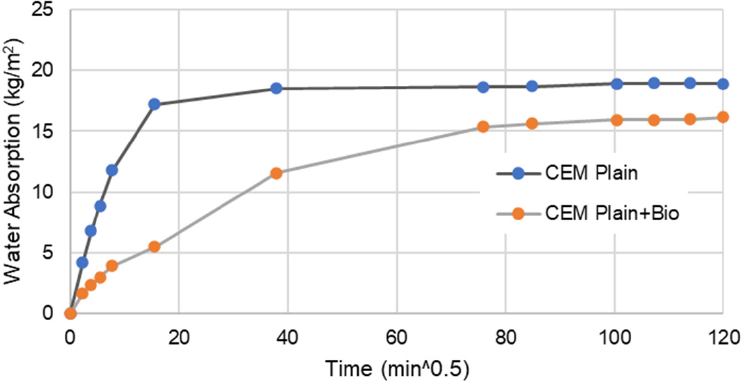
Figure 6. Water absorption for bio and non-bio earth mortar samples during the first 1 h.